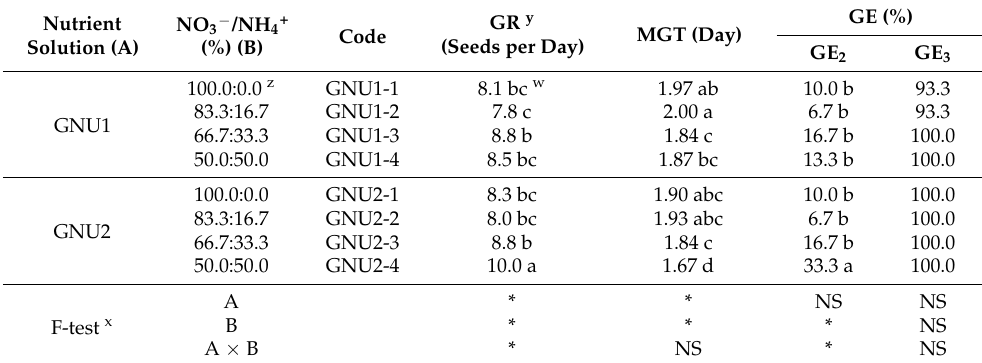
Table 2. Germination rate (GR), mean germination time (MGT), and germination energy (GE) of Ssamchoo as affected by the nutrient solution in the experiment